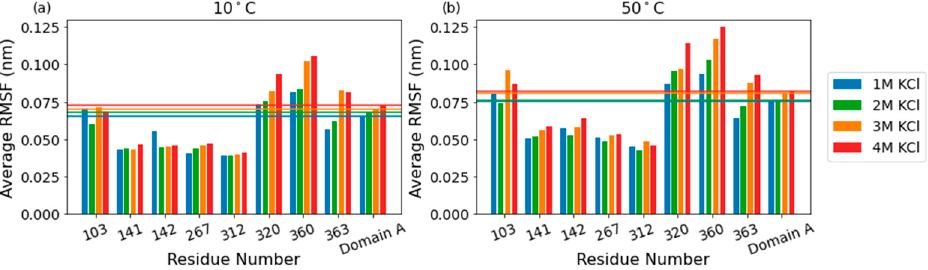
Figure 4. Bar graphs showing the RMSF values of the eight active site residues at 10 ◦ C ( a ) and 50 ◦ C ( b ). The average RMSF values per molarity for domain A are shown as horizontal lines. The low RMSF values observed in domain A and the relatively unperturbed RMSF values in the eight catalytic core residues suggested that flexibility of the solvent-exposed residues of the protein might be correlated to solvent exposure. To test this idea, we defined the surface of the protein as the set of residues that contain an atom which exceeds a solvent-accessible surface area (SASA) cutoff value. This SASA cutoff value was set as the 80th percentile of the average SASA per atom values for each set of conditions (Figure S2). The most flexible residues are on the surface of the protein, while the flexibility of the interior of the protein remains more constant throughout the different temperatures, which is expected for globular proteins (Figure 5). The RMSF of solvent-exposed residues increases by 5.6% from 1 M to 4 M KCl at 10 ◦ C and by 0.4% from 1 M to 4 M at 50 ◦ C, while the RMSF of non-solvent-exposed residues increases by 12.1% and 9.2% from 1 M to 4 M at 10 ◦ C and 50 ◦ C, respectively. The RMSF of solvent-exposed residues increases by 20.8% from 10 ◦ C to 50 ◦ C in 1 M KCl and by 14.8% from 10 ◦ C to 50 ◦ C in 4 M KCl, while the RMSF of non-solvent-exposed residues increases by 15.5% and 12.5% from 10 ◦ C to 50 ◦ C at 1 M and 4 M KCl, respectively. The solvent-exposed residues have a higher percent increase in RMSF compared to the non-solvent-exposed residues when the temperature increases from 10 ◦ C to 50 ◦ C in both 1 M and 4 M KCl, and the non-solvent-exposed residues have a higher percent increase in RMSF compared to the solvent-exposed residues when the molarity increases from 1 M to 4 M KCl at both 10 ◦ C and 50 ◦ C.